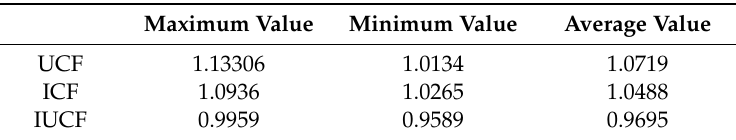
Table 5. Statistical results of RMSE.